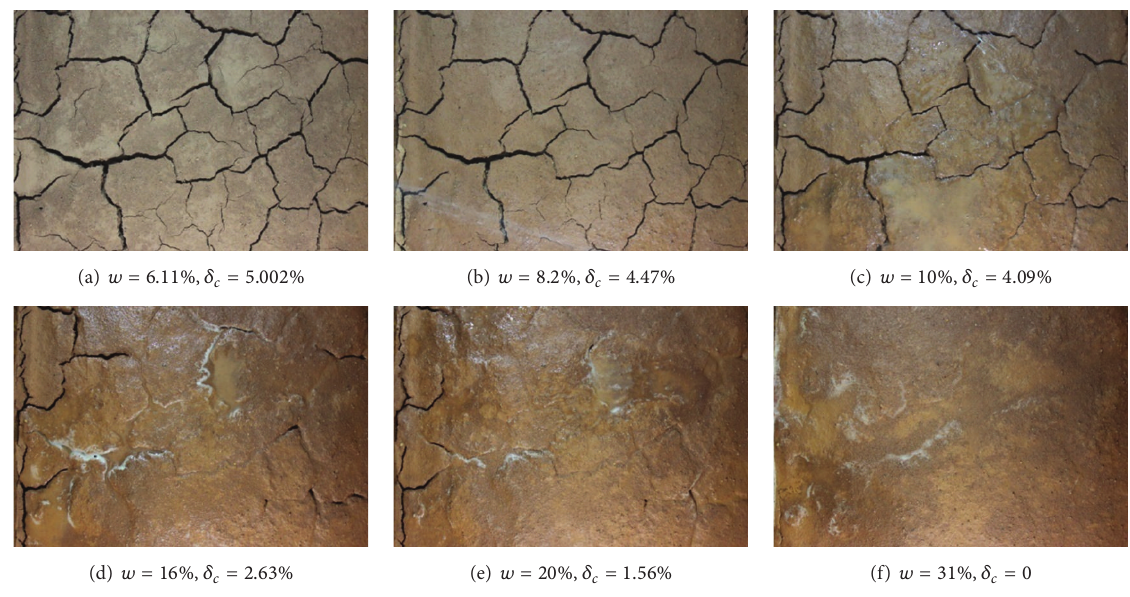
Figure 4: Crack development during a wetting